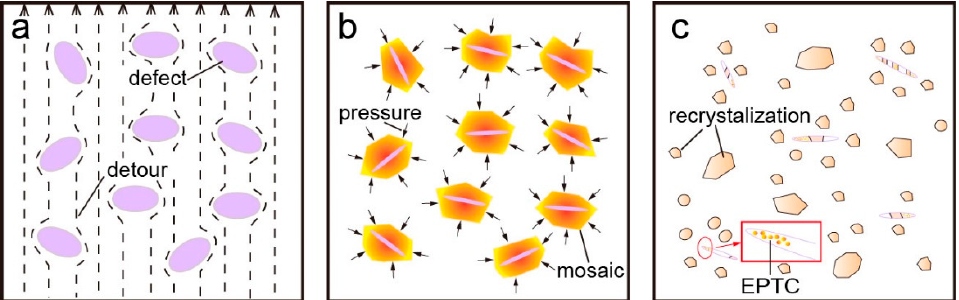
Figure 9. Schematic diagram of defect healing and recrystallization: ( a ) plastic deformation to form defects and defective areas of the current bypass; ( b ) the formation of pressure around the metal defects; ( c ) healing defects, recrystallization and high energy EPT cladding (EPTC) [55,124].